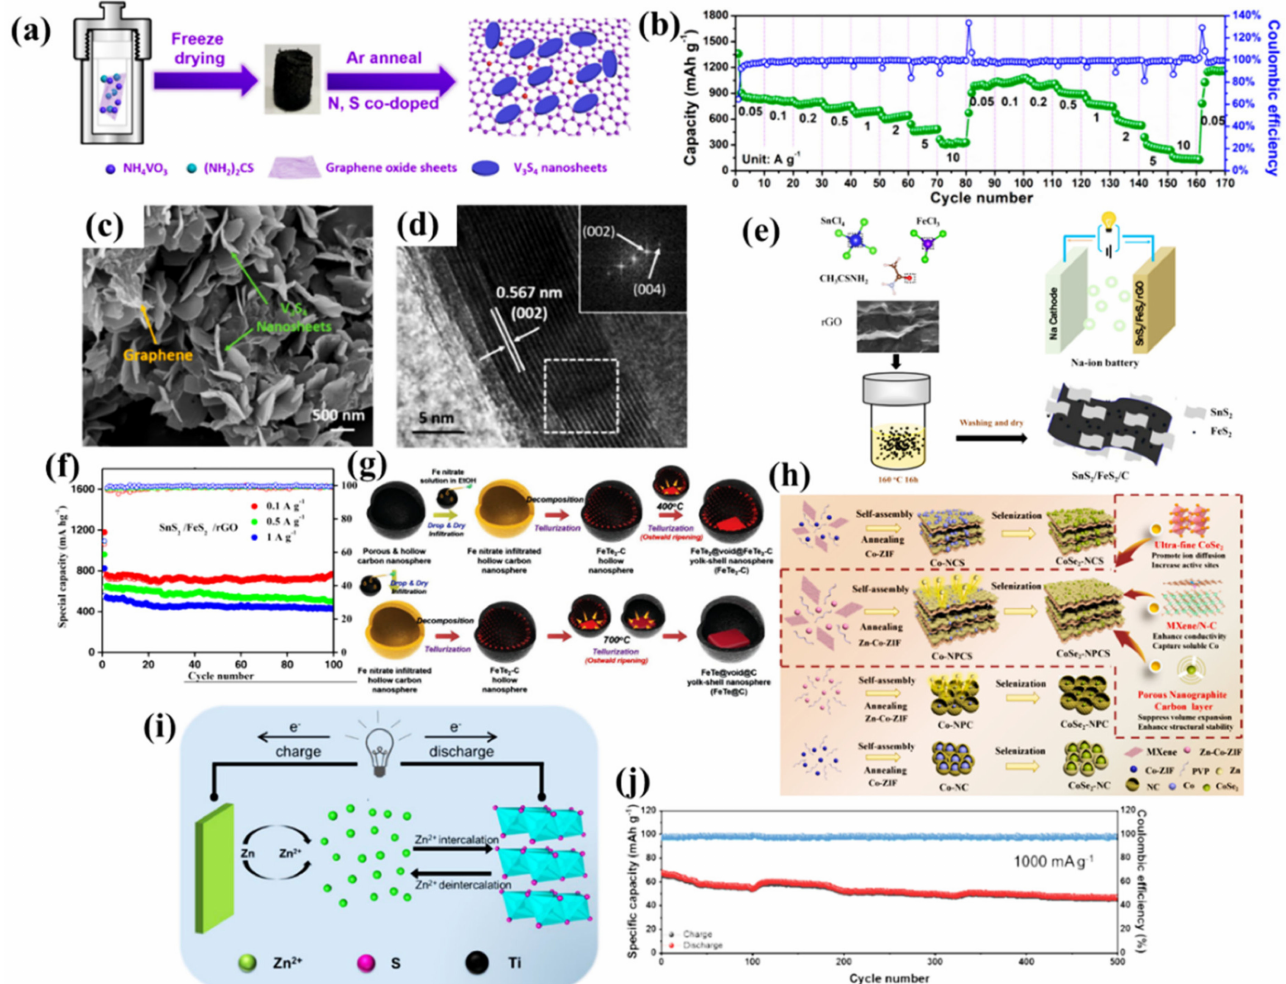
Figure 12. ( a ) A schematic representation of the VS/NSG electrode preparation method. ( b )